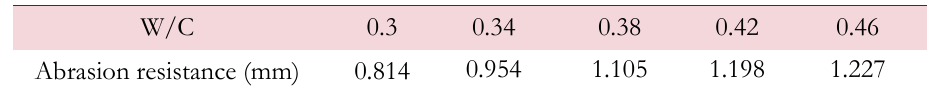
Table 2: Abrasion depth tests for specimens with variable water-cement